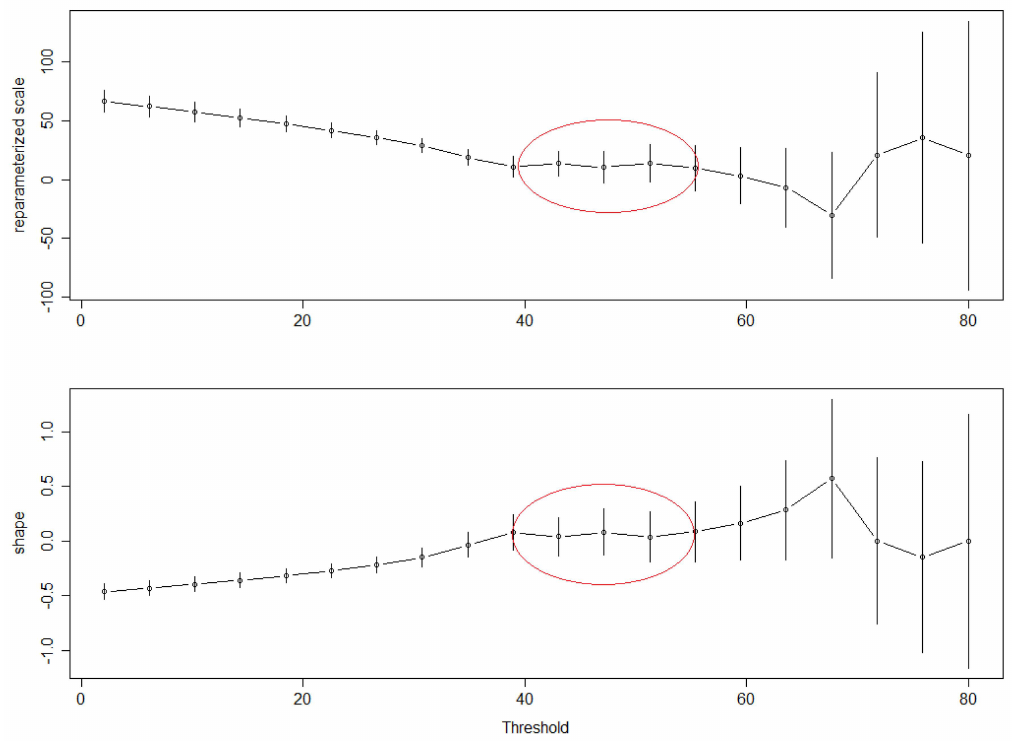
Figure A3. Parameter estimates against threshold for daily rainfall data at Bonou station (second sub-samples).